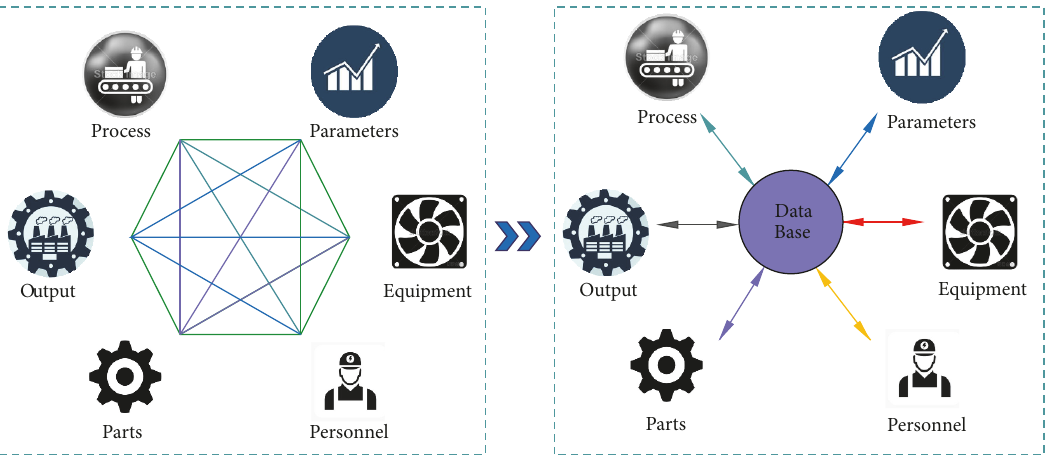
Figure 2: Changes in Information Exchange Models.